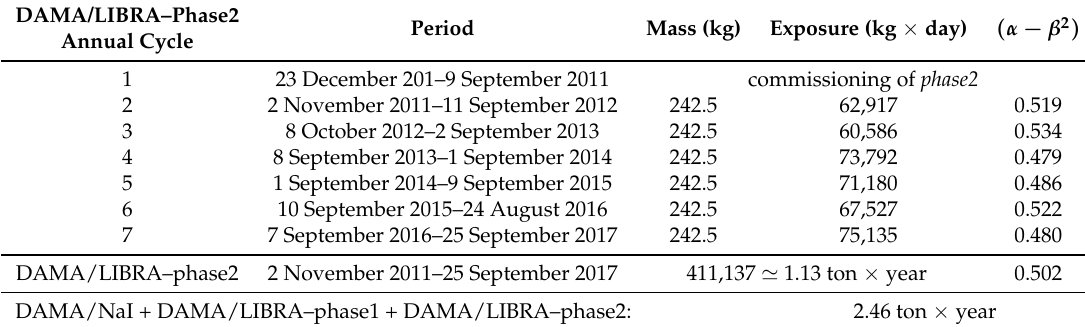
Table 1. Details about the annual cycles of DAMA/LIBRA–phase2. The mean value of the squared cosine is α = (cid:104) cos 2 ω ( t − t 0 ) (cid:105) and the mean value of the cosine is β = (cid:104) cos ω ( t − t 0 ) (cid:105) (the averages are taken over the live time of the data taking and t 0 = 152.5 day, i.e., 2 June); thus, the variance of the cosine, ( α − β 2 ) , is (cid:39) 0.5 for a detector being operational evenly throughout the year.